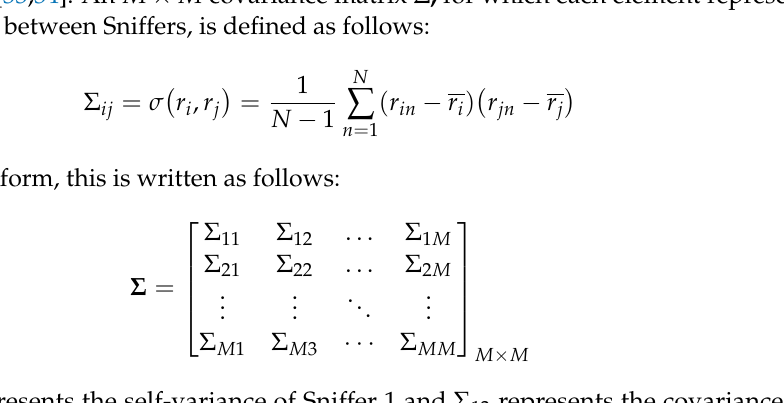
where Σ 11 represents the self-variance of Sniffer 1 and Σ 12 represents the covariance be- tween Sniffers 1 and